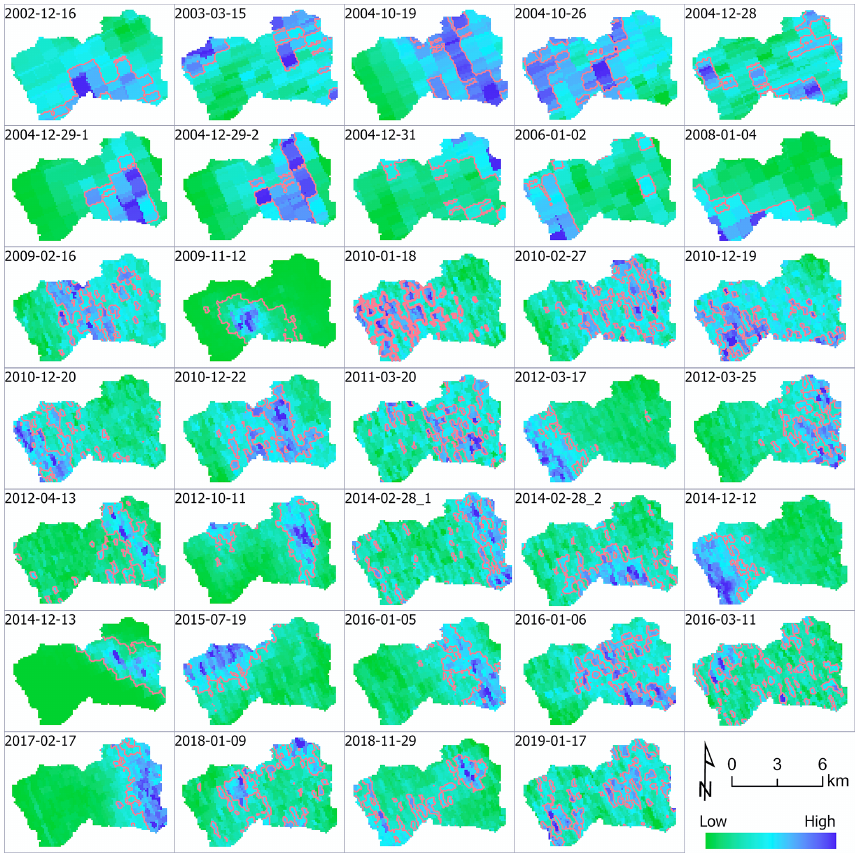
Figure 9. Snapshots of the spatial patterns of I 75 of 34 unique storms. The peak j th percentile of I D (rainfall intensity over a duration D ) 30 is denoted as I j . I 75 is the peak value of the 75th percentile of I 30 (rainfall intensity over 30min). Red contours delineate the pixels with D 30 of each rainfall intensities larger than I 75 30